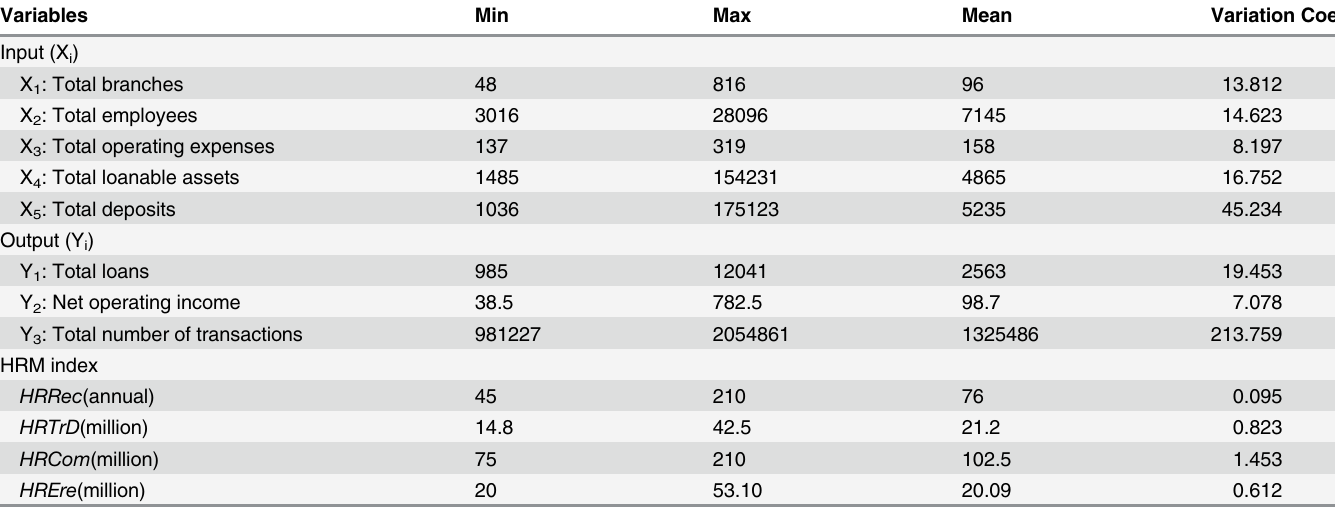
Table 1. Summary statistics of Data, 2008 –